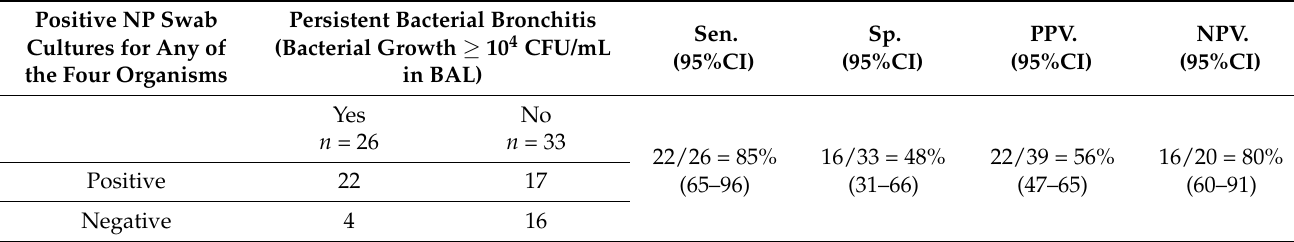
Table 3. Sensitivity, specificity, positive predictive value, and negative predictive value of nasopharyngeal swab for the diagnosis of persistent bacterial bronchitis in children < 5 years.